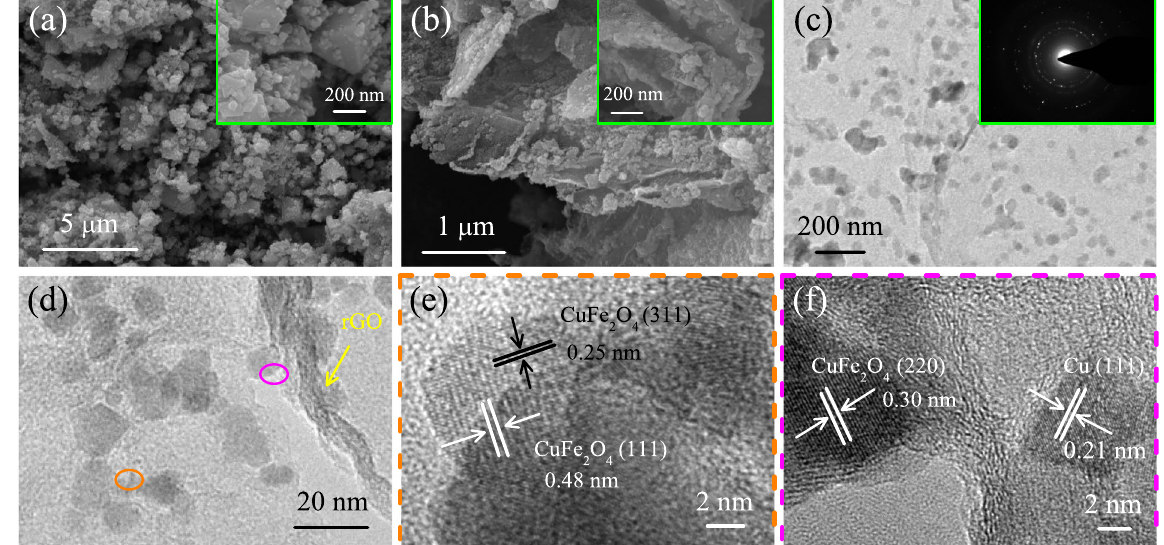
Figure 6. ( a ) SEM image of Cu/CuFe 2 O 4 , inset shows the higher magnification. ( b ) SEM image of Cu/ CuFe 2 O 4 @rGO, inset shows the higher magnification. ( c ) TEM image of Cu/CuFe 2 O 4 @rGO, inset shows the selected area electron diffraction (SAED) pattern. ( d ) High magnitude TEM image of Cu/CuFe 2 O 4 @rGO. ( e , f ) HRTEM images of Cu/CuFe 2 O 4